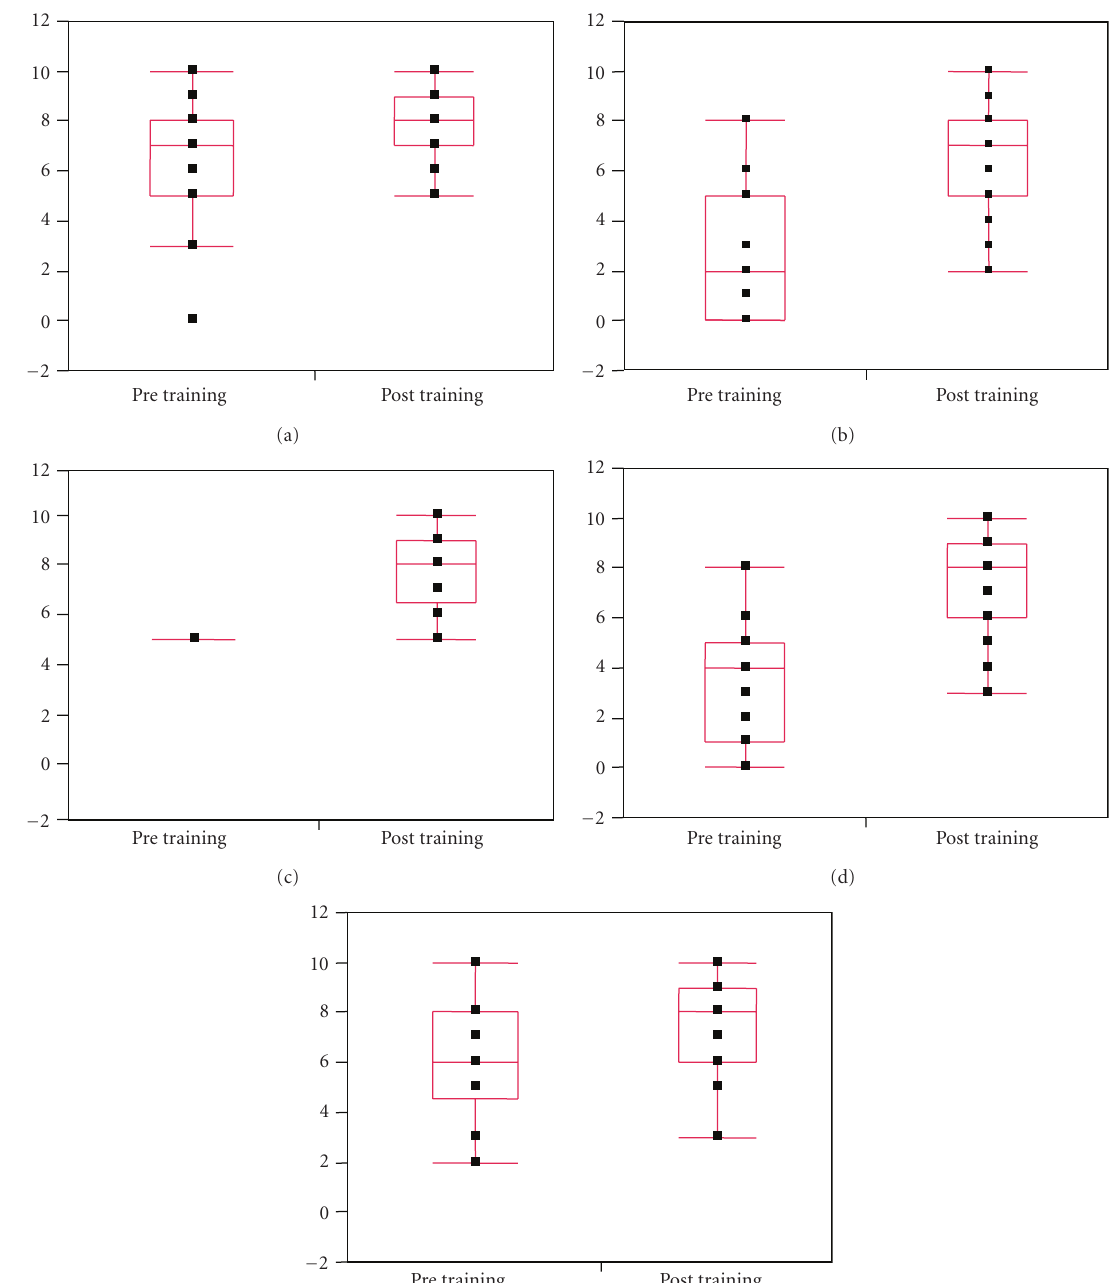
Figure 2: Quantile Box Plots schematically demonstrating pre and post session surveys obtained from residents completing the training session. (a) Comfort level with lysis of adhesion (Mean Scores: 6.3 versus 7.7, P = . 007); (b) Comfort level with enterotomy repair (Mean Scores: 2.8 versus 6.4, P < . 0001); (c) Knowledge of principles of lysis of adhesion (Mean Scores: 5.0 versus 7.7, P < . 0001); (d) Knowledge of principles of enterotomy repair (Mean Scores: 3.5 versus 7.0, P < . 0001); (e) Familiarity with instruments used with bowel surgery (Mean Scores: 5.8 versus 7.3, P = .